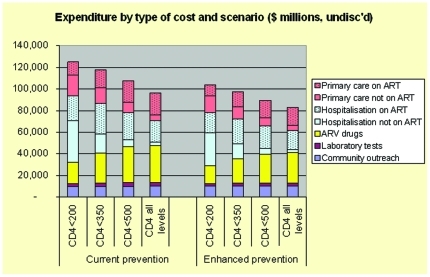
Undiscounted expenditure over 40 years by type of cost and scenario.These histograms show how projected expenditures over 40 years vary as a function of the ART scenario. As ART intensity rises, overall spending drops, with a modest rise in ARV drug costs and a larger drop in hospital costs.